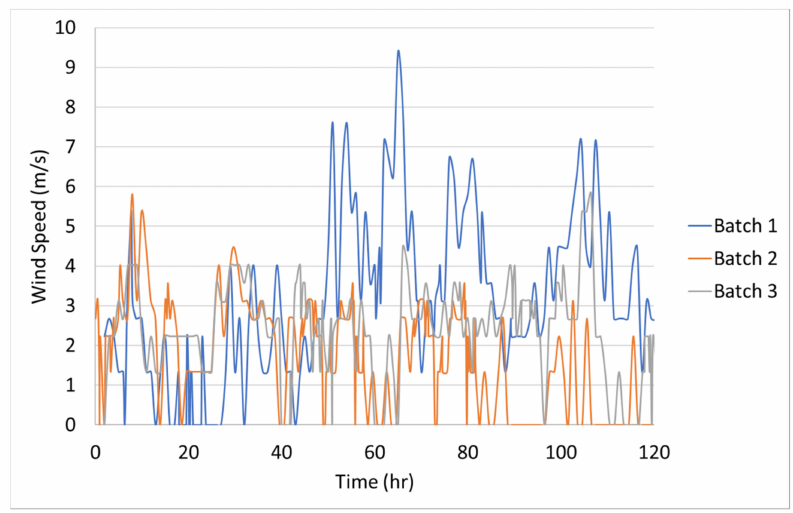
Figure 10. Wind speed during 1.2-m (4-ft) cube